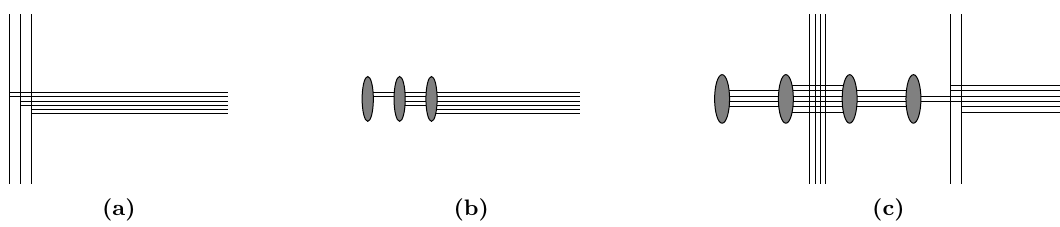
Figure 2. Left: BCFT with semi-infinite D3-branes ending on D5-branes, corresponding to Nahm- pole boundary conditions. Center: S-dual configuration with semi-infinite D3-branes ending on NS5 branes, corresponding to 4d N = 4 SYM coupled to a non-trivial 3d SCFT. Right: configuration with D3-branes ending on a combination of D5 and NS5